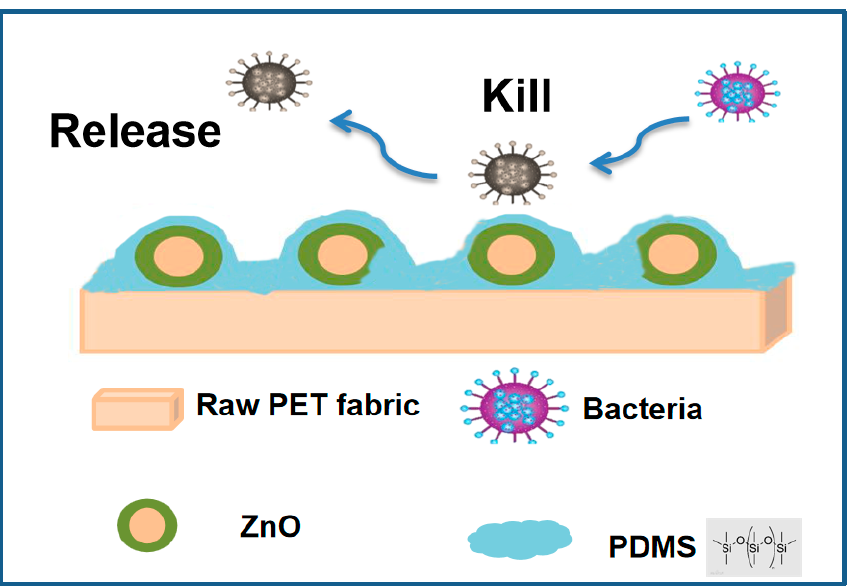
Figure 6. Antibacterial adhesion tests. ( a ) Antibacterial adhesion rate of different fabric, with E. coli and S. aureus bacteria; ( b ) The state of different PET fabrics in liquid culture medium.